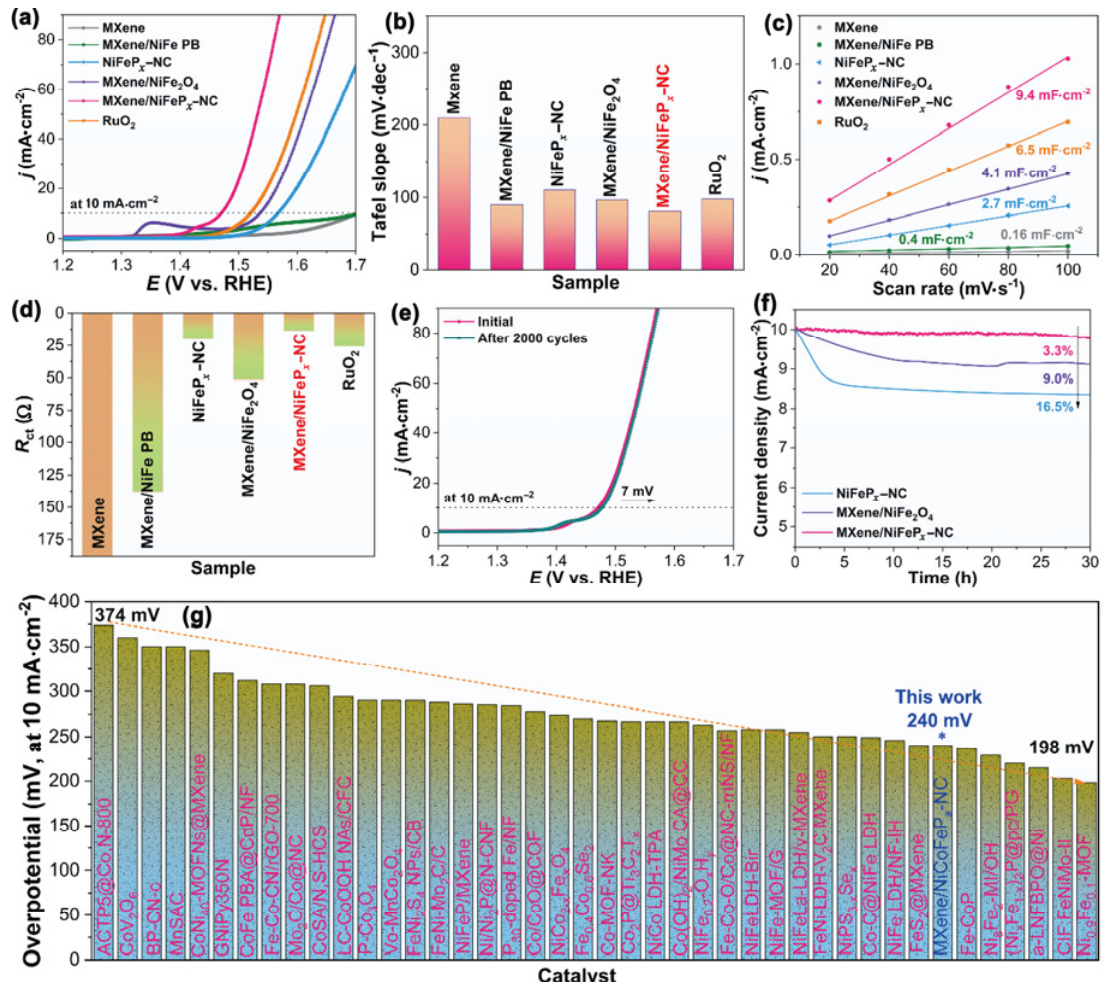
Fig. 4 (a) OER polarization curves, (b) corresponding Tafel slope, (c) C dl , and (d) Nyquist EIS spectra of